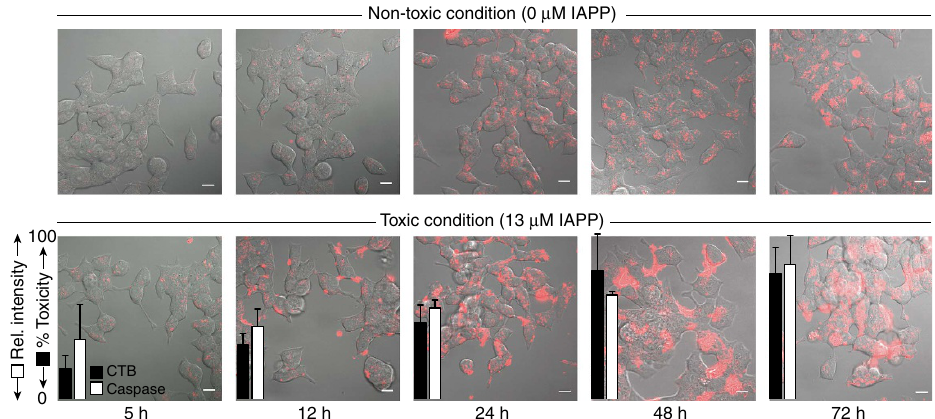
Figure 2 | Time-dependent uptake of IAPP and toxicity. At time zero, 100nM IAPP A594 with (toxic) and without (non-toxic) an additional 13 m M of unlabelled IAPP was added to culture media of INS-1 cells. Confocal images were taken at the indicated time points. Three biological replicates were performed. Scale bar, 10 m m. Inset: colourimetric evaluation of toxicity (CellTiter Blue) and apoptosis (using caspase-3) at the toxic condition relative to vehicle-only controls. Each time point is the average of eight on-plate repeats from each of three independently performed replicates ( n ¼ 24). rel., relative.